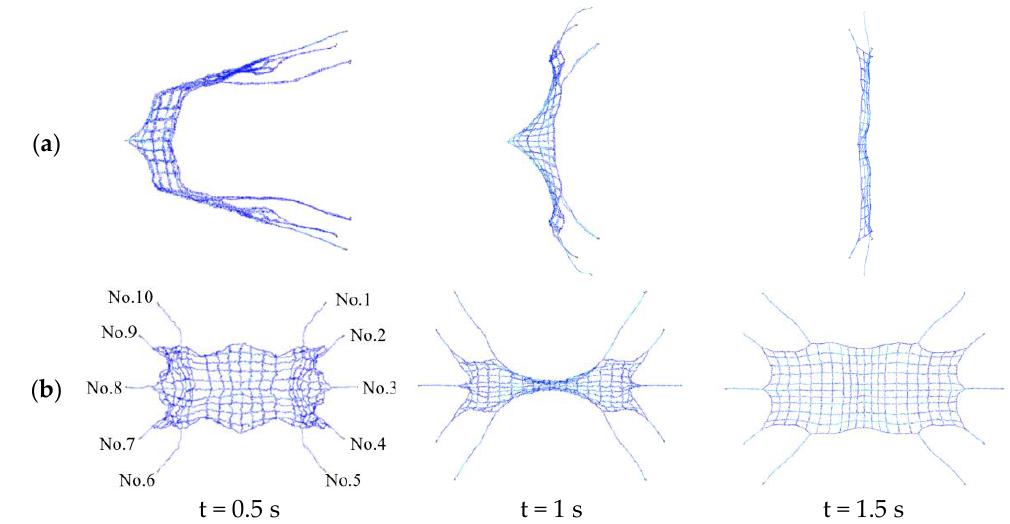
Figure 14. Configuration of tether-net during deployment with initial parameters. ( a ) Main view.